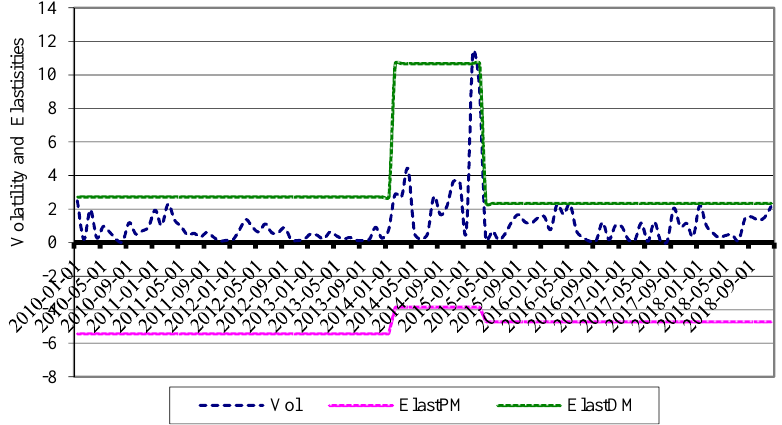
Figure 3. Superimposing graphs of elasticities and volatility